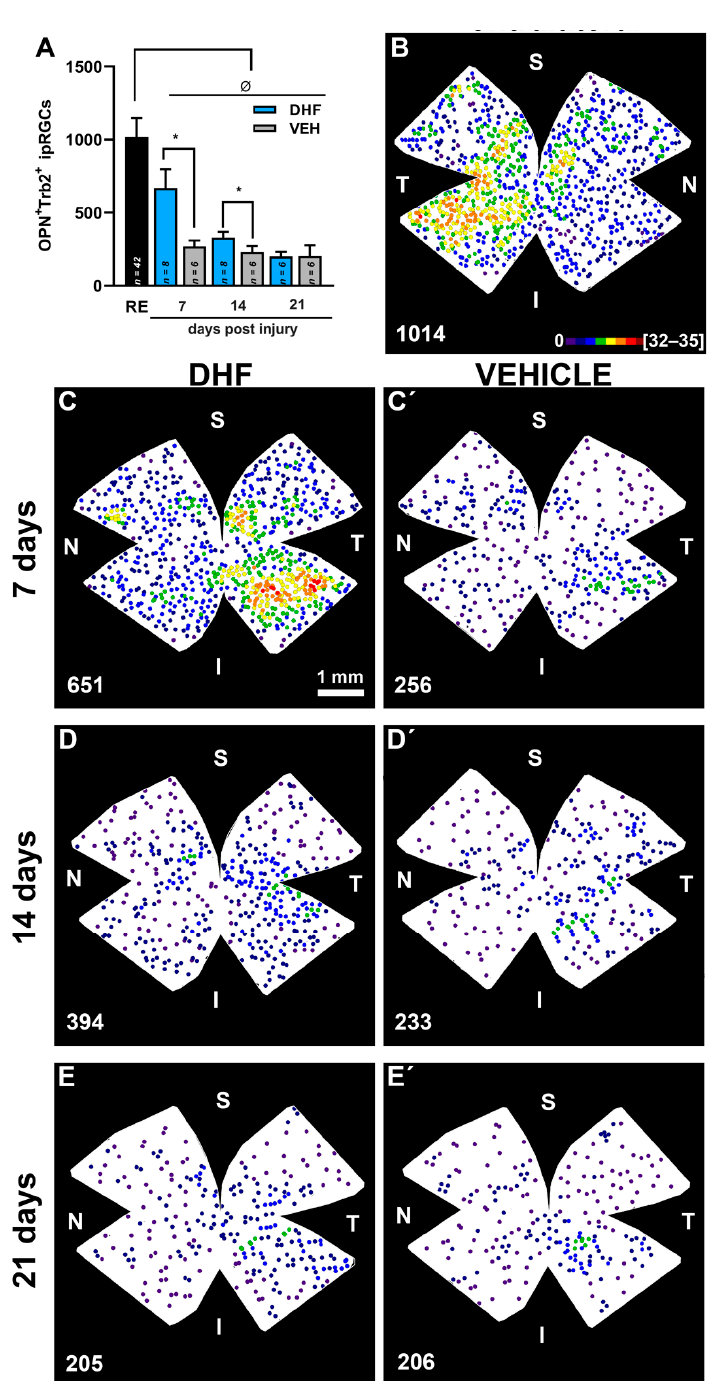
Figure 8. DHF prevents IONT-induced M4-like ipRGCs loss. In adult albino rats, the left optic nerve was intraorbitally transected and animals were treated i.p. daily with vehicle (VEH) (1% DMSO